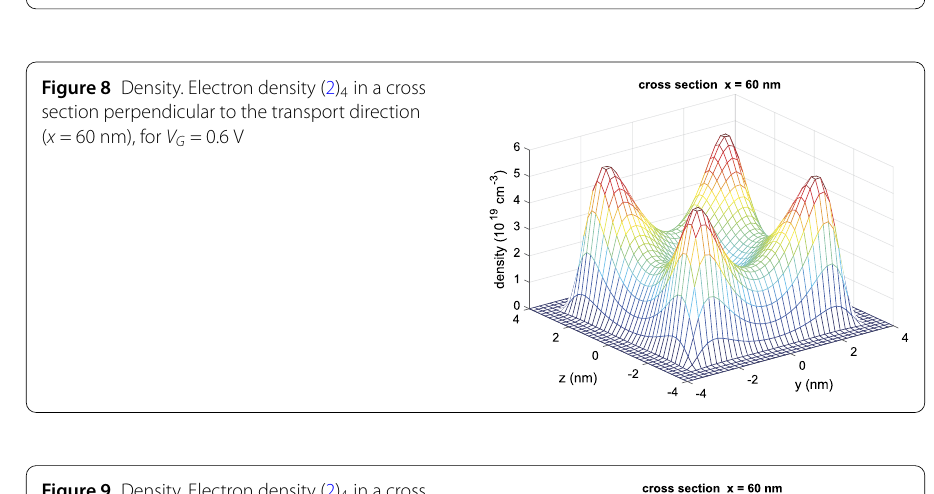
Figure 9 Density. Electron density (2) 4 in a cross section perpendicular to the transport direction ( x = 60 nm), for V G = 1